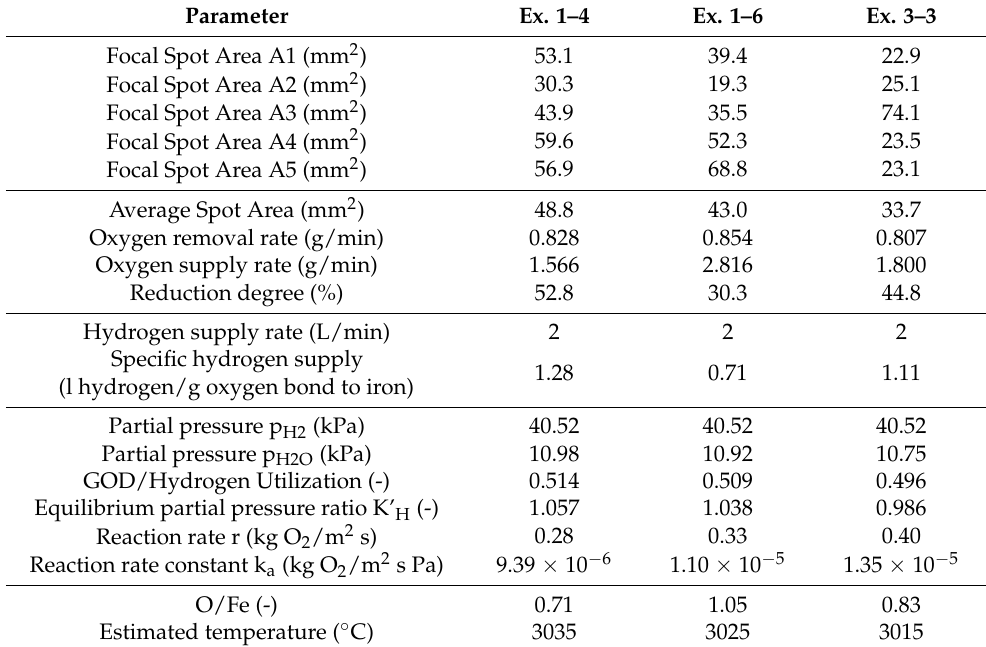
Table 9. Experiment evaluation during iron ore